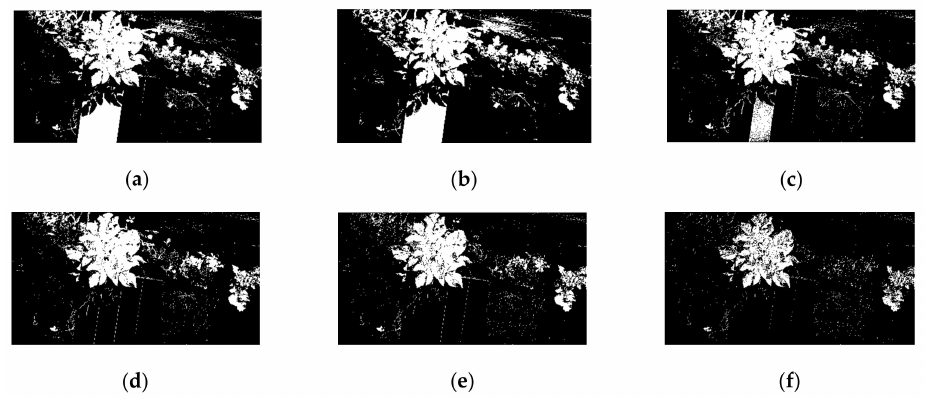
Figure 7. Segmentation result using MDVI–OTSU method under six modified coe ffi cients. ( a ) α = 0.5; ( b ) α = 1.0; ( c ) α = 1.5; ( d ) α = 2.0; ( e ) α = 2.5; ( f ) α =